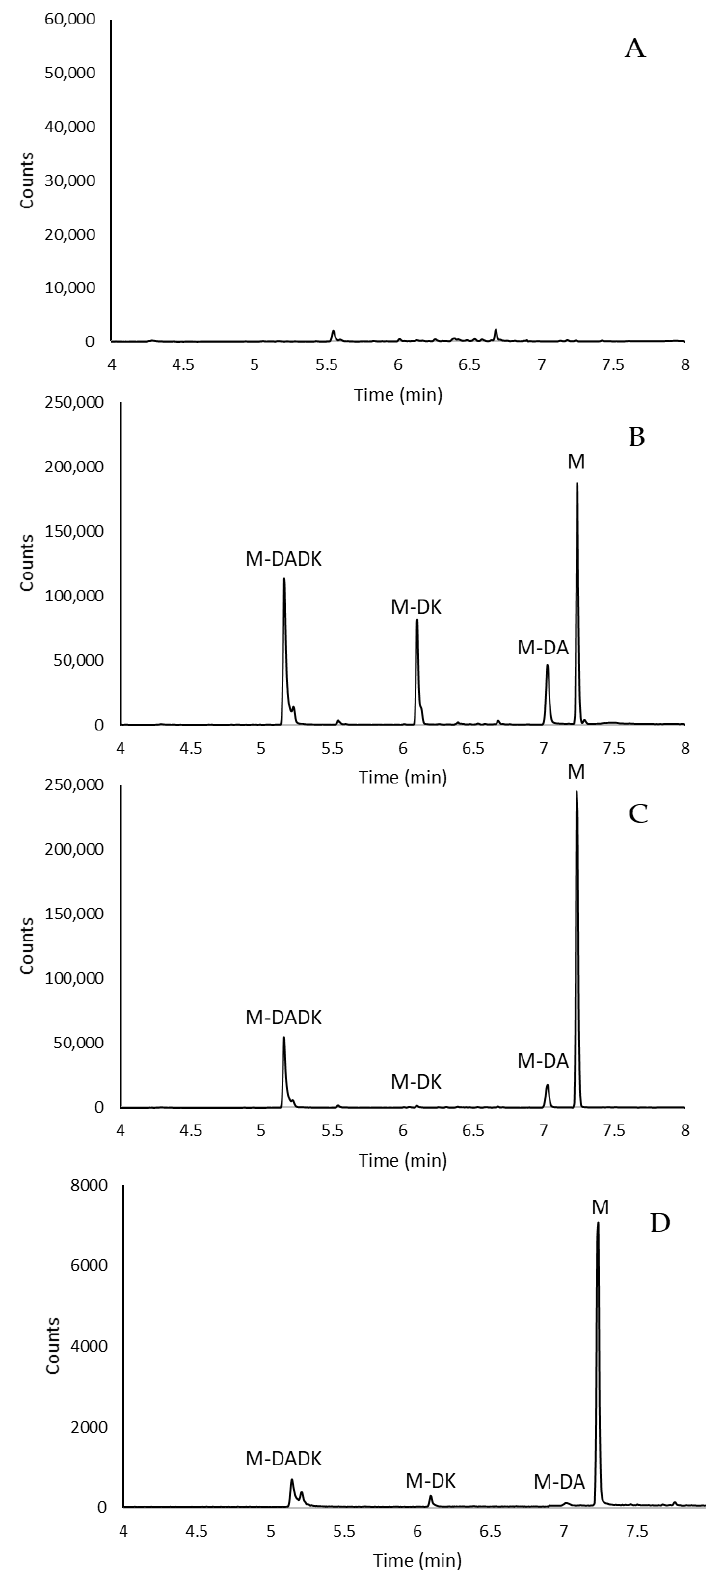
Figure 2. TIC chromatograms of ( A ) a blank plant extract; ( B ) a blank plant extract spiked at 500 ng/L with metribuzin and its metabolites; ( C ) bean plant sample grown in soil treated with metribuzin (2 mg/kg) and ( D ) soil sample collected 23 days after treatment with metribuzin.